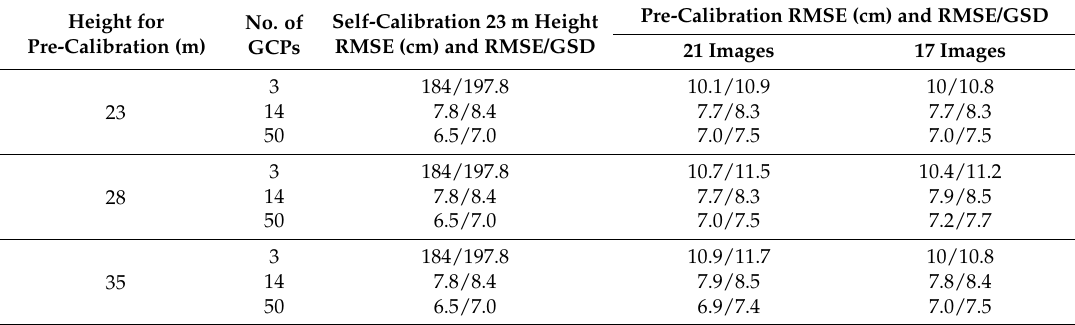
Table 9. The residuals of 100 CPs for a 28 m nadiral flight when using self-calibration and pre-calibration at 3 different heights: 23 m, 28 m and 35 m with two image configuration in the case of a different number of GCPs.